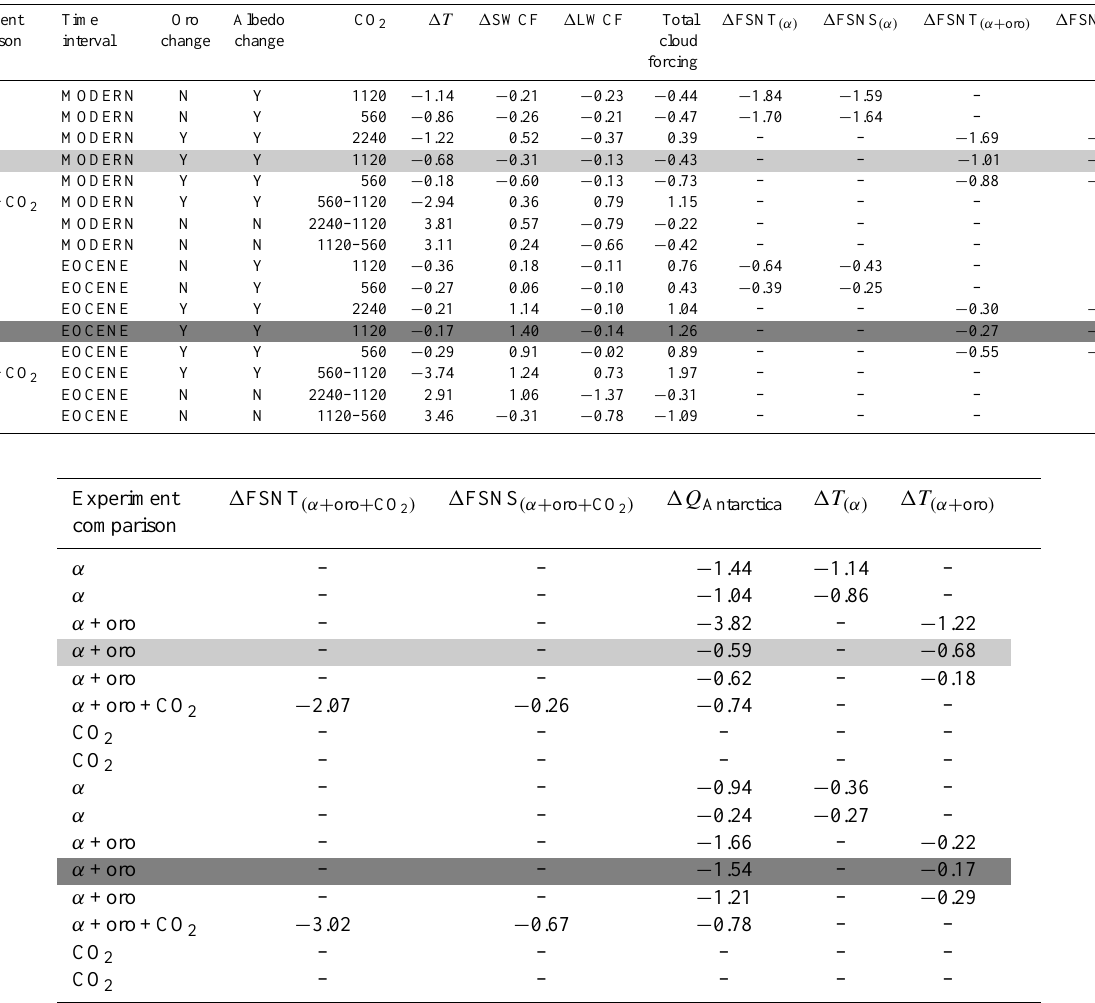
Table 1. Eocene and modern glaciated minus unglaciated simulations labeled by experiment type, time interval, orography change (labelled Y(yes) and N(no)), albedo change (labelled with Y and N), and atmospheric CO 2 in ppm. Globally weighted anomalies are given for 1T in (K), 1 SWCF, 1 LWCF, and total cloud forcing SWCF+LWCF in Wm − 2 . Second, the table lists 1 FSNT and the globally weighted Antarctic forcings ( 1Q Antarctica ) calculated using FSNSC (adjusted effective forcing see text in section 2.3). Third, the table gives values for the surface temperature sensitivity induced by the changes in albedo, topography, and CO 2 , such as 1T (α) : the change in surface temperature due to the albedo forcing of the AIS, and 1T (α + oro ) : the temperature change due to the albedo of the ice sheet and the topography of the ice sheet. Lastly, the table calculates ESS and S in K(Wm − 2 ) − 1 using the different 1T and 1Q Antarctica values. Where S [ Antarctica , CO sensitivity to changing CO 2 , Antarctic albedo, Antarctic topography and S [ Antarctica ] are the sensitivity of climate to changes in Antarctic ice sheet holding atmospheric CO 2 constant. Complete descriptions of the equations are written in detail in methods Sect.